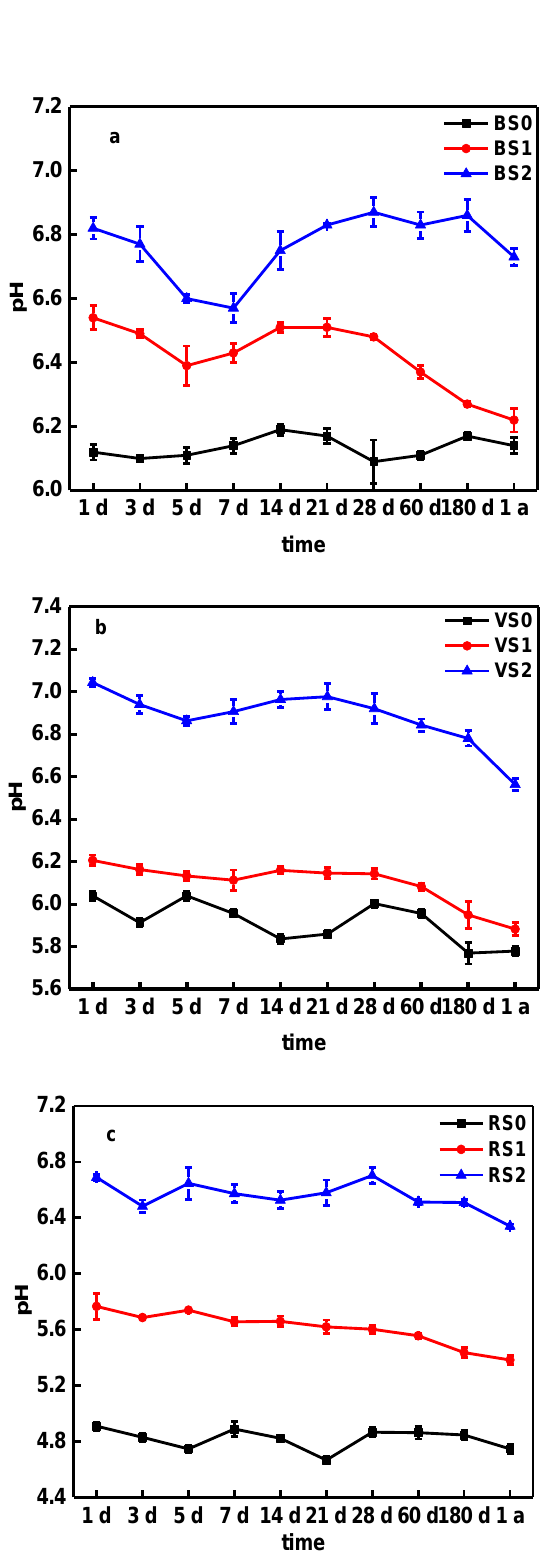
Figure 2. The change of pH in BS ( a ), VS ( b ) and RS ( c ) soils amended with biochars. Note: Error bars are standard deviations of the means ( n = 3). (BS0: black soil, BS1: black soil + BC300, BS2: black soil + BC600, VS0: Vegetable garden soil, VS1: Vegetable garden soil + BC300, VS2: Vegetable garden soil + BC600, RS0, Red soil, RS1: Red soil + BC300, RS2: Red soil + BC600).